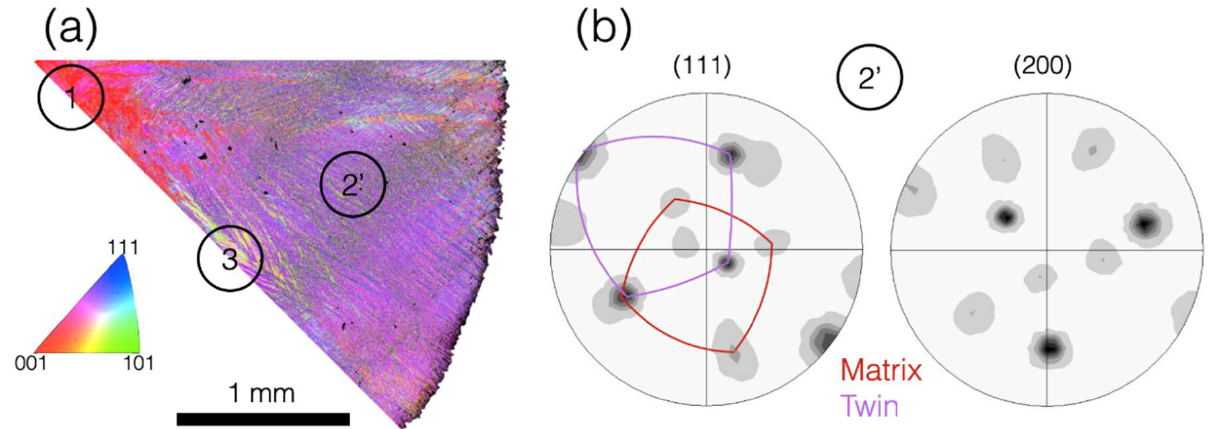
Figure 4. EBSD analysis of one 1/8 crystal section deformed to the 1.1 of the true strain: IPF map with marked characteristic regions ( a ), (111) and (200) pole figures from the regions 2’ ( b ).